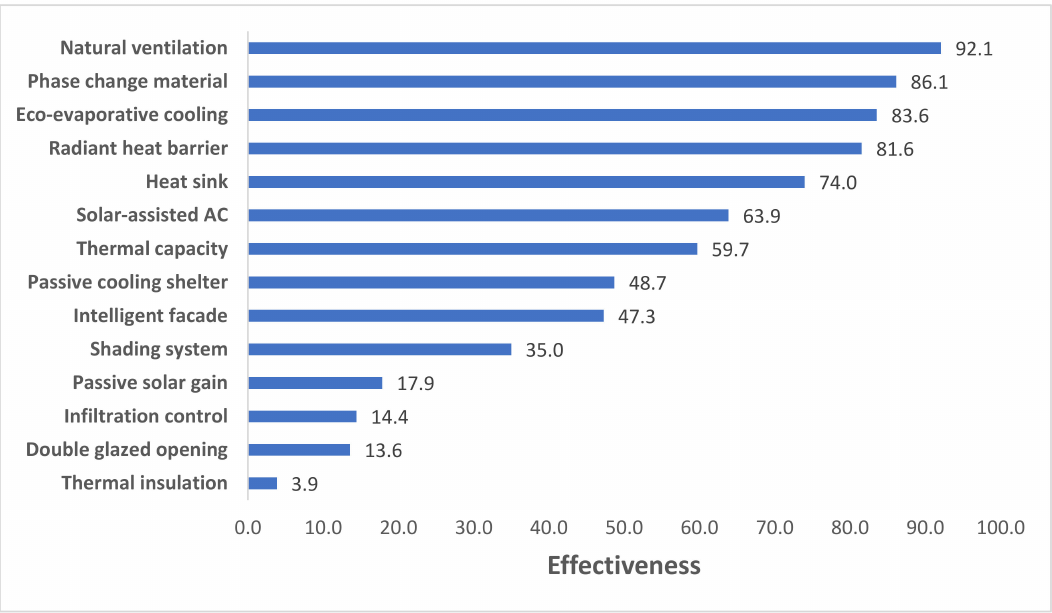
Figure 7. E ff ectiveness of the passive methods for a comfort temperature of 22 ◦ C and having a driving by the